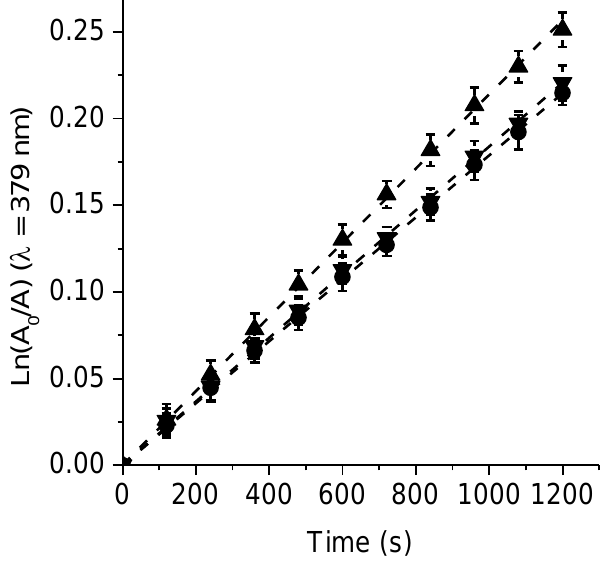
Figure 4. First-order plots for the photooxidation of DMA sensitized by PTPPF 16 -EDA ( (cid:72) ), PZnTPPF 16 -EDA ( (cid:78) ) and ZnTMP ( • ) in DMF, λ irr = 424 nm (0.34 mW/cm 2 ).